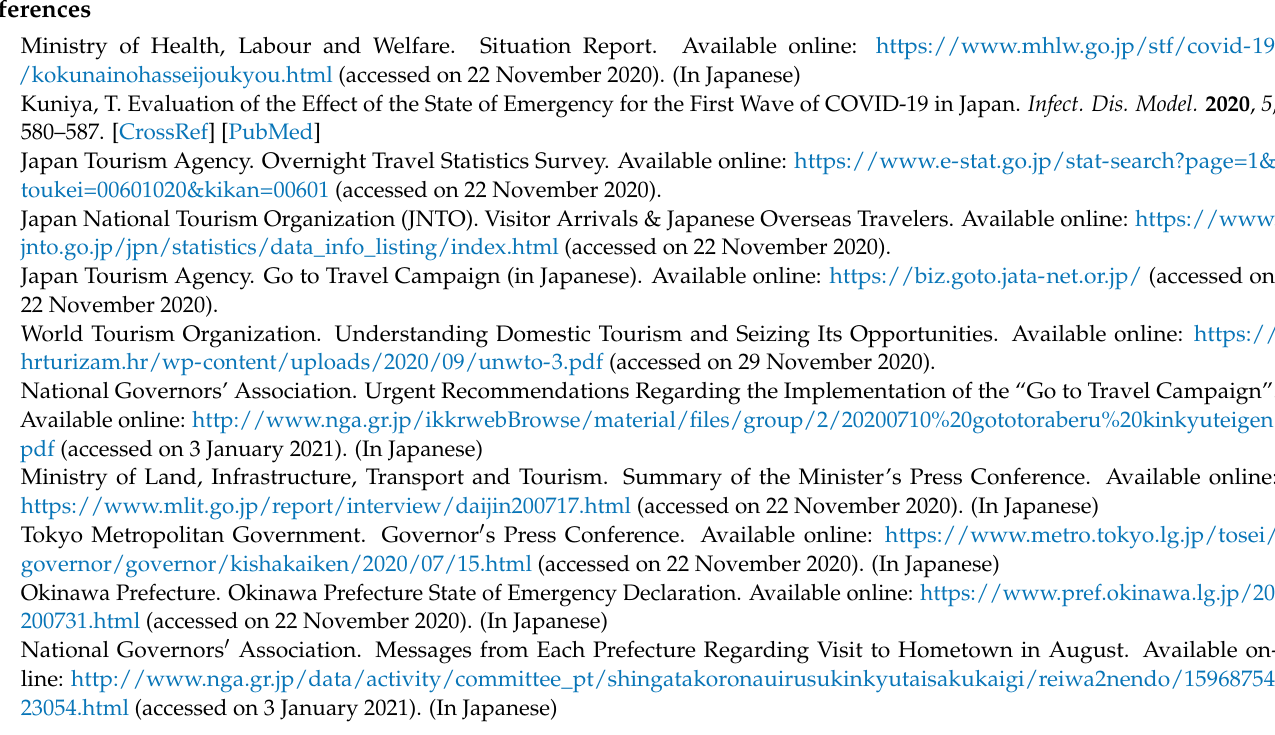
Table S2: Nubmer of cases with travel history and with known purpose of